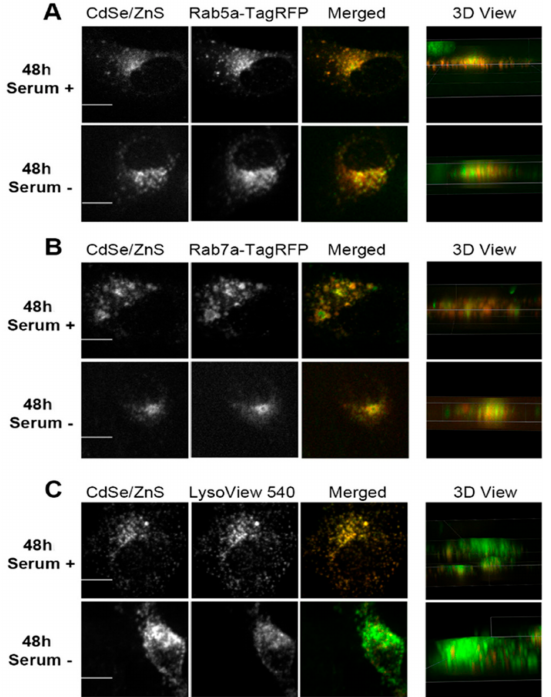
Figure 7. Representative confocal microscope images depicting subcellular localizations of